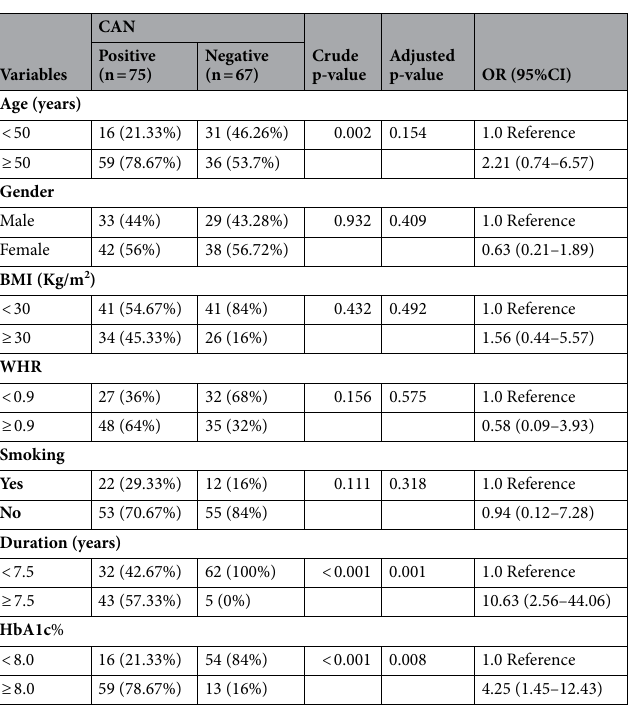
Table 6. Predictors of cardiac autonomic neuropathy (using multiple regression). CAN = cardiac autonomic neuropathy; BMI = body mass index; WHR = waist-hip